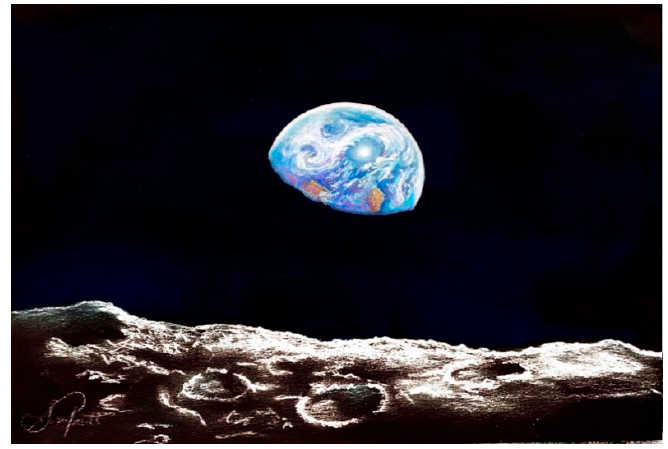
Figure 1. Earthrise. Inspired by the photograph taken by Apollo 8 Astronaut William Anders; one of the most influential images in human history. Artwork by SLP.